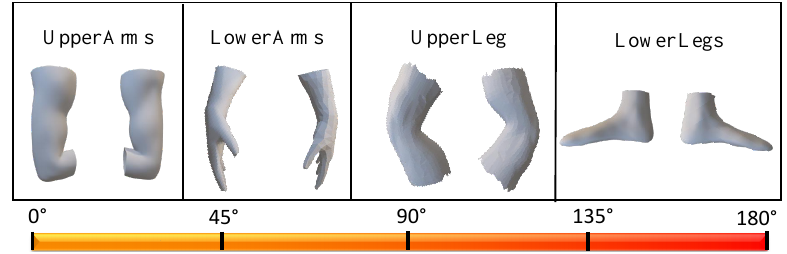
Figure 5. 3D Models adopted to intuitively visualize the twist. A gradient color is used to color the models based the degree of twist.